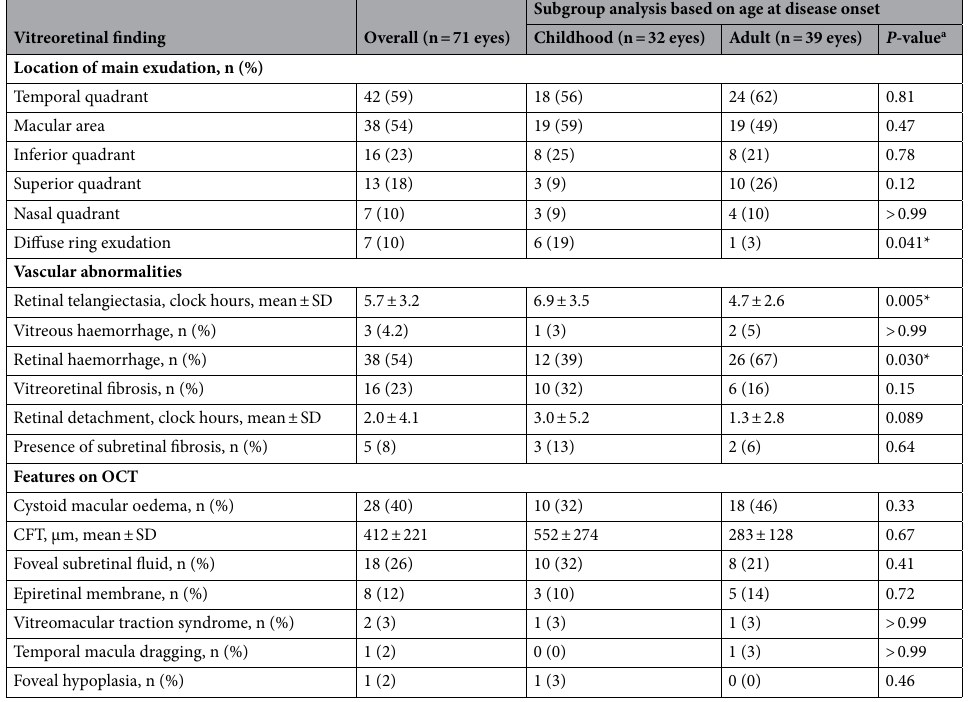
Table 2. Vitreoretinal findings at presentation in patients with Coats’ disease. CFT central foveal thickness, logMAR logarithm of minimum angle of resolution, OCT optical coherence tomography. * P -values of < 0.05 are considered statistically significant. a The chi-squared test and Student’s